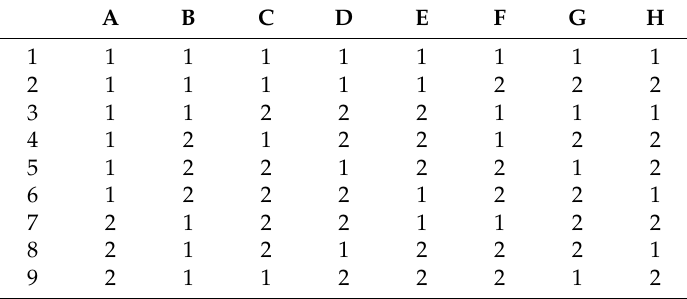
Table 4. The eight-factor and two-level orthogonal